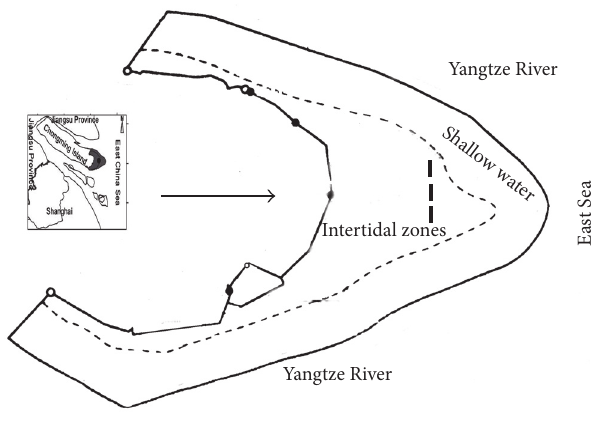
Figure 1: The transects setting in the middle-low tidal zone of Chongming Dongtan wetland,